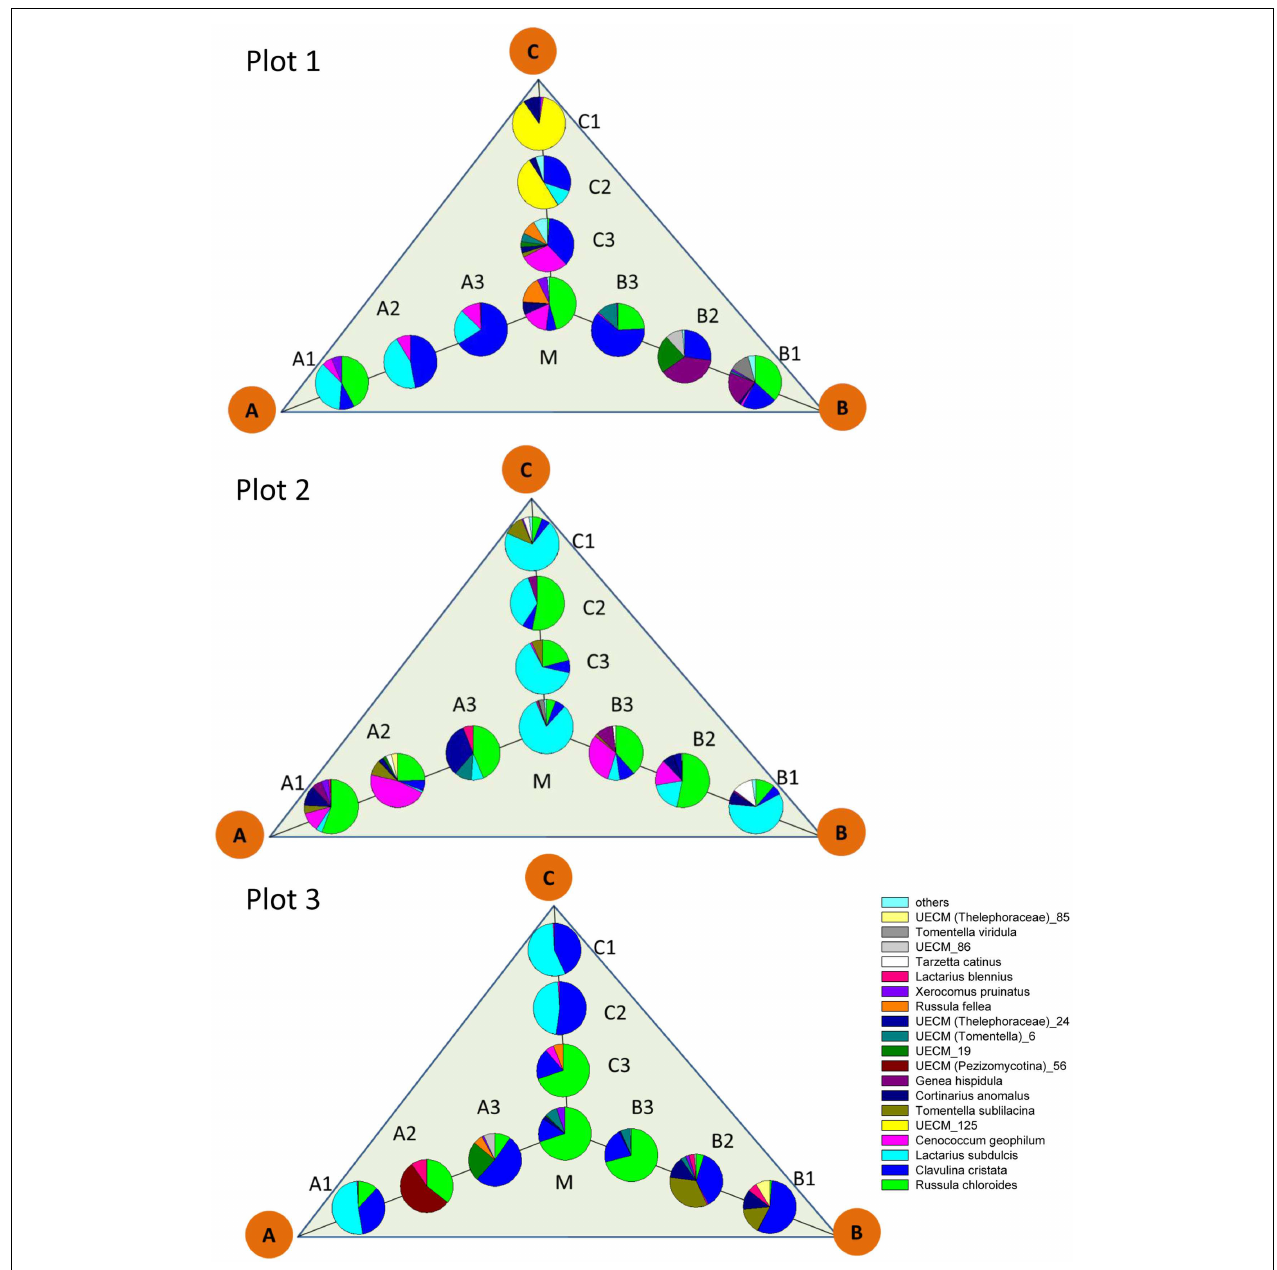
FIGURE 4 | Scheme of localization and relative abundance of EcM species in 1L soil cores. Abbreviations for the positon of the soil cores as in Figure 1 . Others: sum of UECM_73, T. coerulea , Inocybe sp., Sebacina sp., T. puberulum , R. delicia , UECM (Terfeziaceae)_109, which accounted together for < 1% of the total EcM